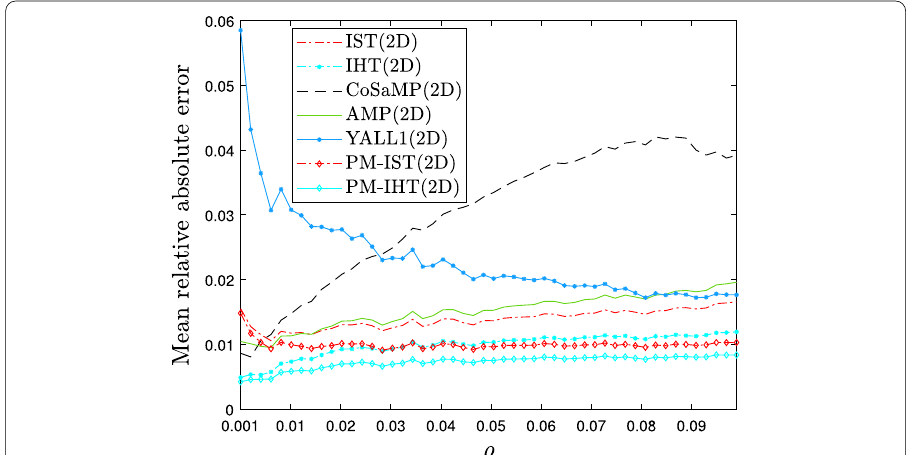
Fig. 10 Mean relative absolute error of 2D algorithms vs. sparsity level ratio ρ